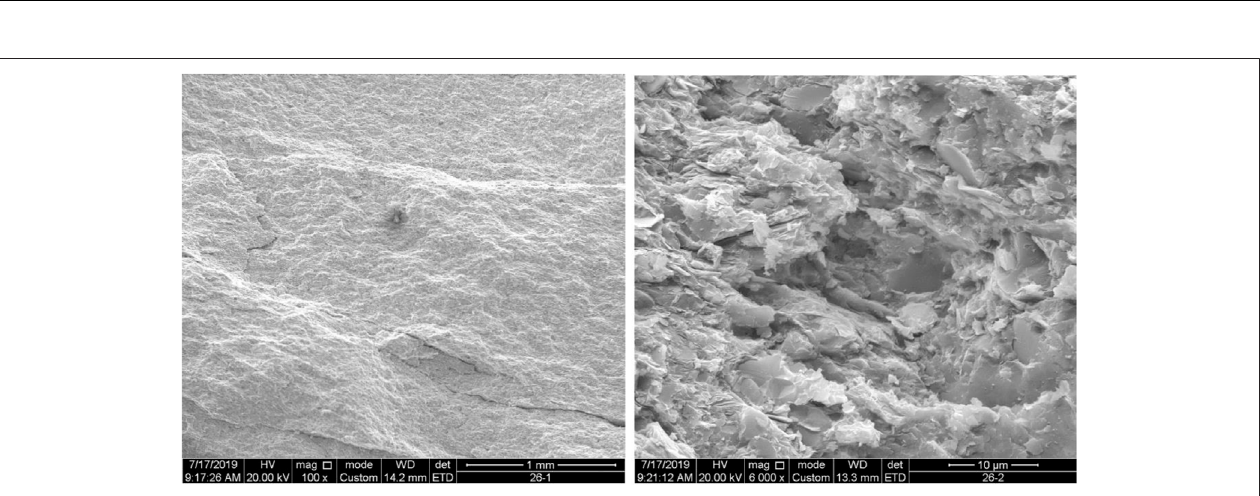
FIGURE 2 | X-ray diffraction (XRD) analysis results for 24 shale samples. (A) Single-core analysis results. (B) Average value.